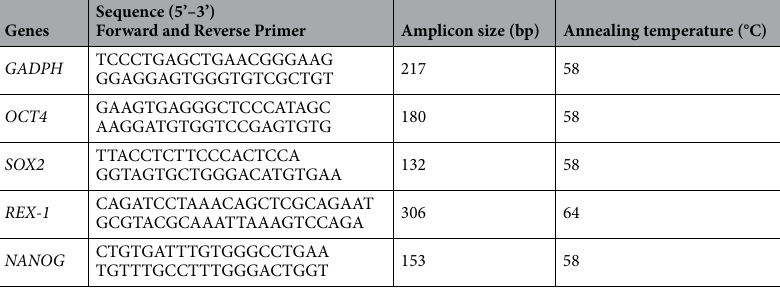
rose gel (SeaKem® LE Agarose, Lonza, Switzerland) and stained with ethidium bromide. The gel was visualized using Syngene Gel Documentation (Syngene, USA). The design of the primers GADPH, REX 1, SOX2 OCT4